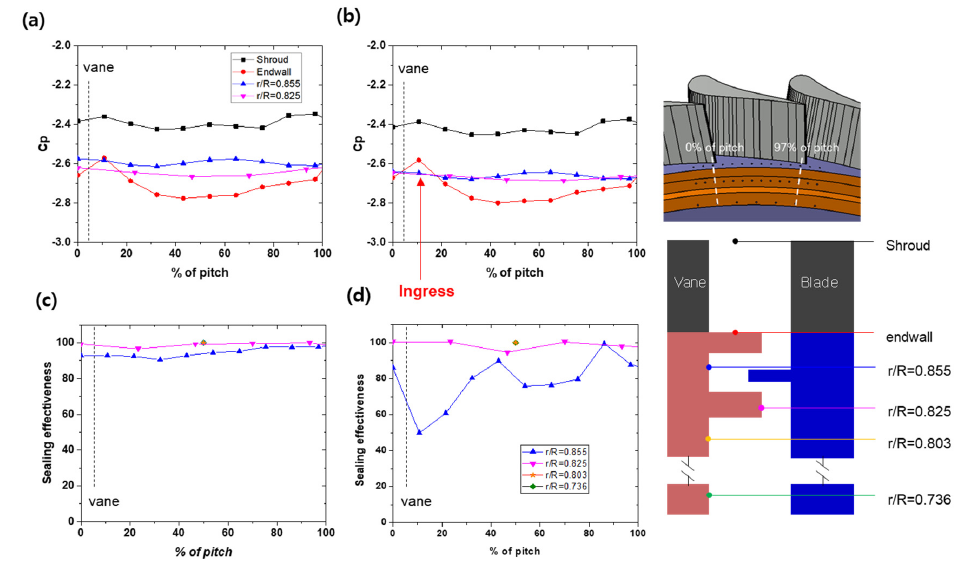
Figure5. Localpressuredistributions: ( a )1.35%and( b )1%actualengineairflow; localseale ff ectiveness: Figure 5. Local pressure distributions: ( a ) 1.35% and ( b ) 1% actual engine air flow; local seal ( c ) 1.35% and ( d ) 1% actual engine air flow at Re φ (cid:27) 5.2 × 10 5 effectiveness: ( c ) 1.35% and ( d ) 1% actual engine air flow at R (cid:3032)(cid:2957) ≅ 5.2 (cid:3400) 10 (cid:2873) .